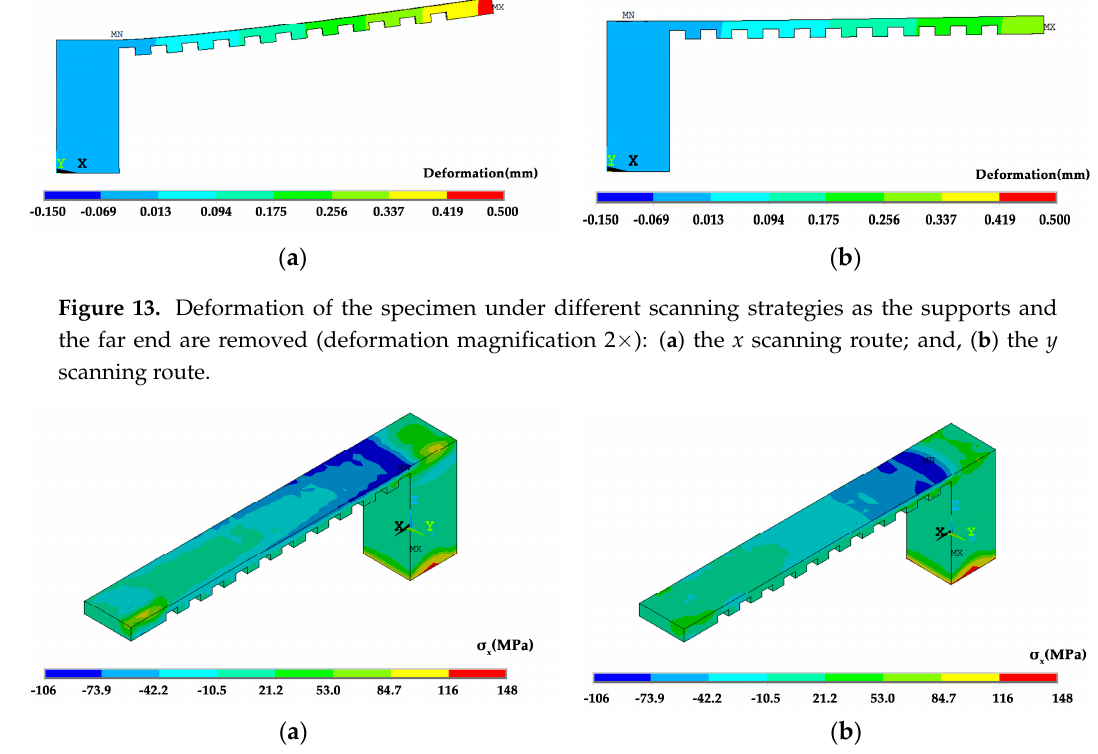
Figure 14. Residual stress σ x of the specimen under different scanning strategies as the supports and the far end are removed: ( a ) the x scanning route; and, ( b ) the y scanning route.